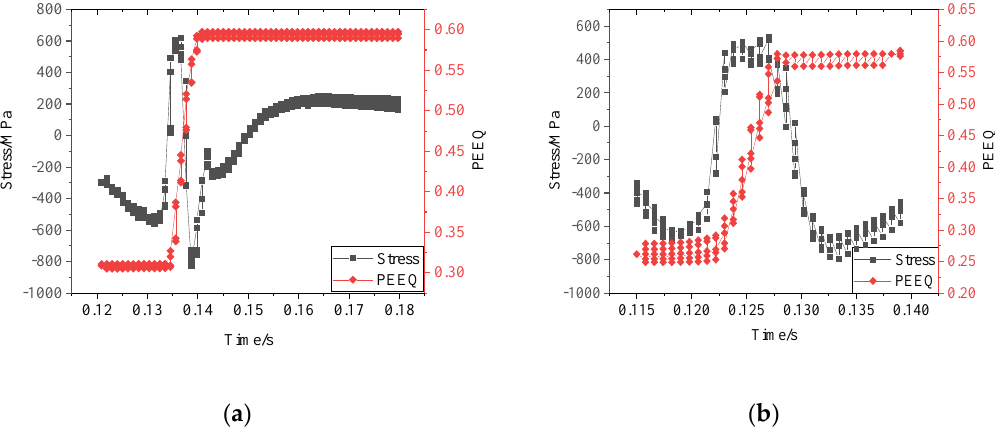
Figure 10. Changes in RD partial stress and strain with time in the second pass of strips with ( a ) 1.5 mm grinding depth and ( b ) 2.0 mm grinding depth.